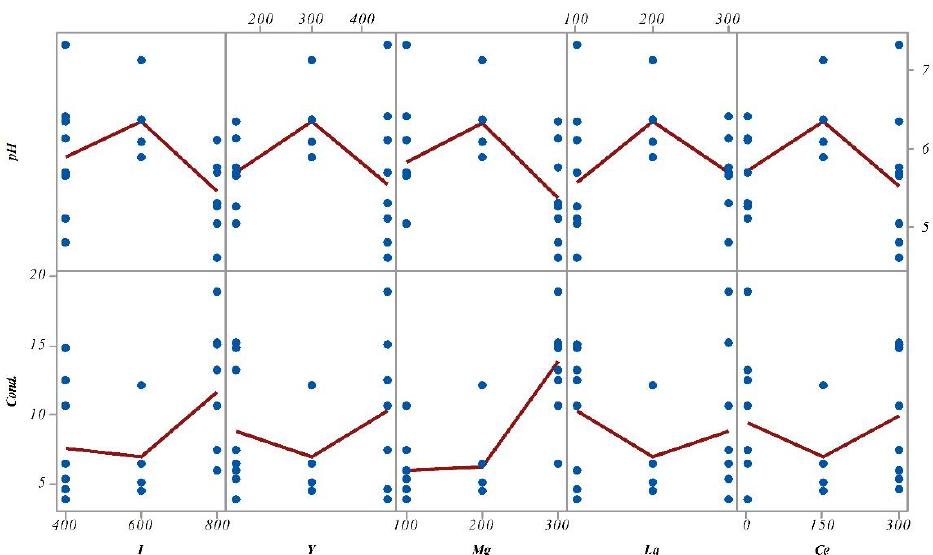
Fig. 9. Matrix plots of conductivity (µS.cm -1 ) and pH vs. additive concentrations (ppm).